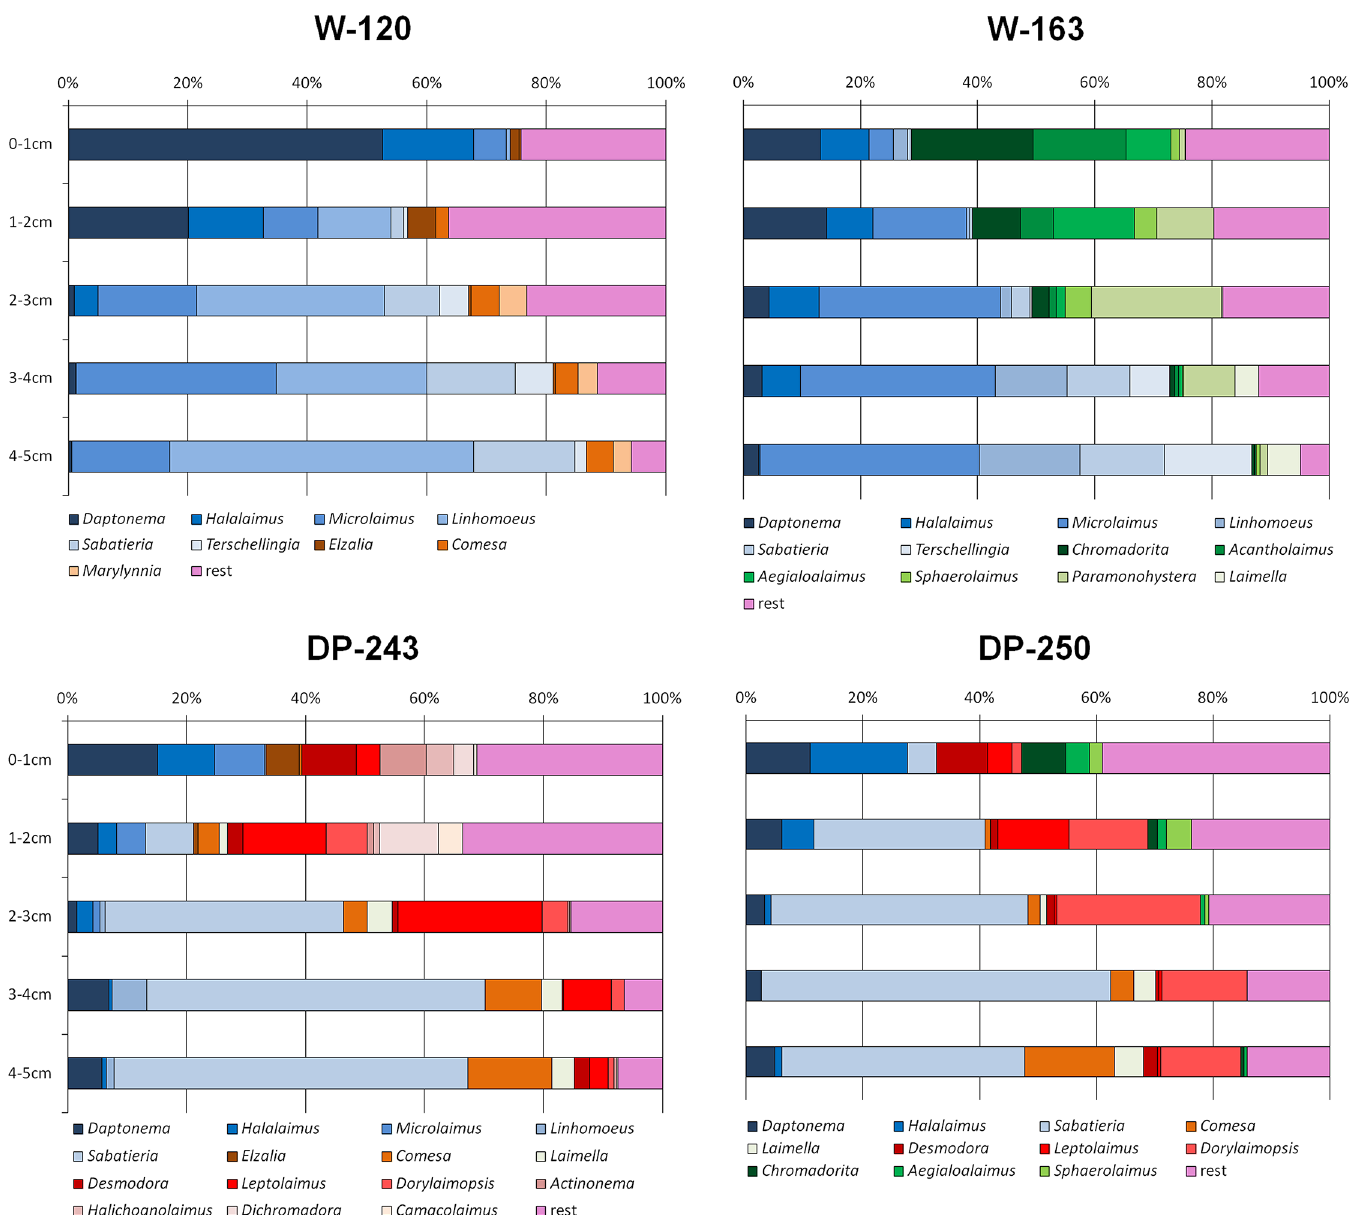
Fig 5. Vertical profiles of relative genus abundances for each station. Only genera with an abundance > 4% in one of the layers were included, all others were grouped as “ rest ” . Where possible, we used the same colours for the same genera in all different